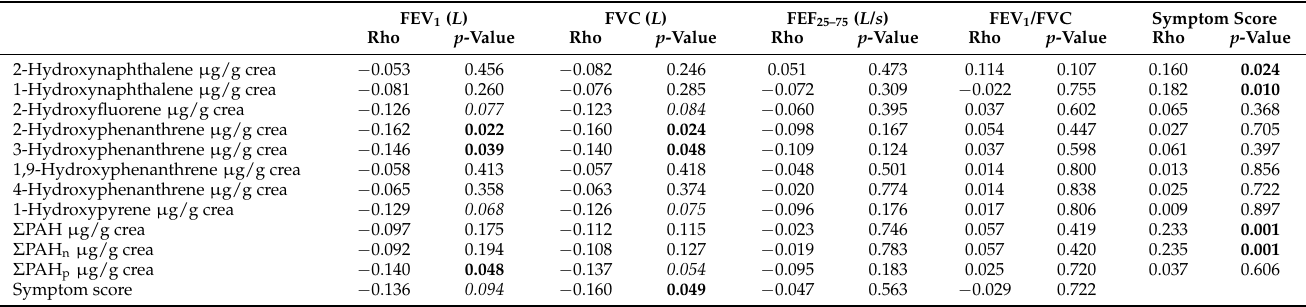
Table 4. Repeated measure correlations of urinary PAHs, spirometry parameters and symptom score.